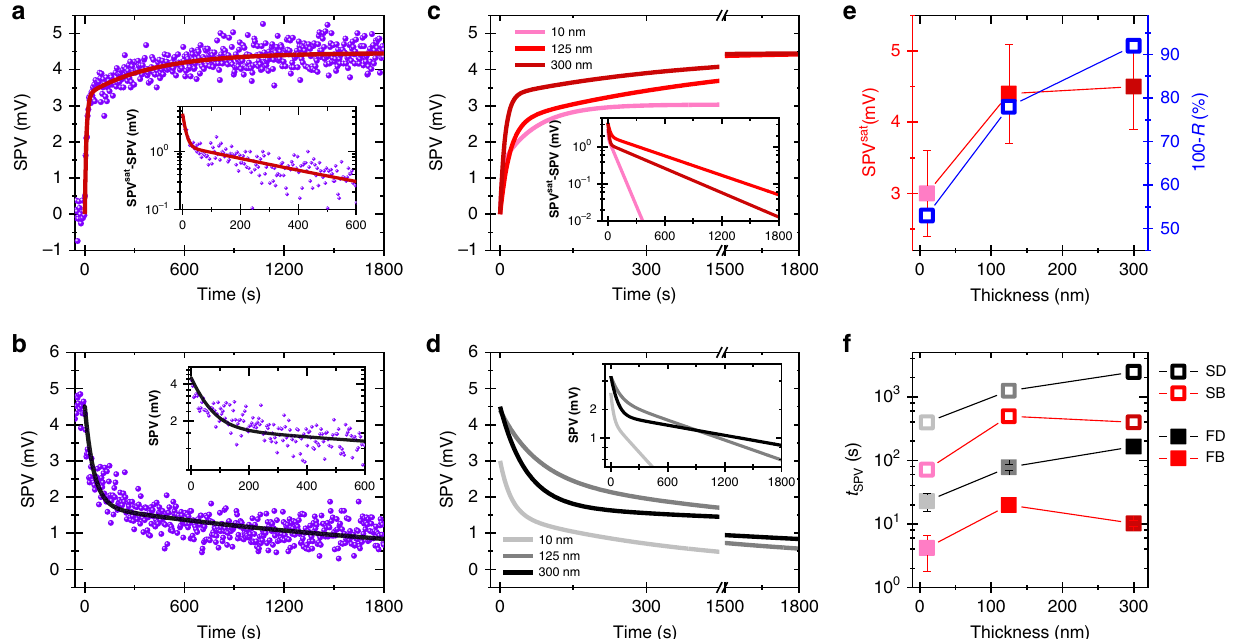
Fig. 4 Surface photovoltages dynamics and amplitudes supported by composite nanostructures. a , b Typical increase and decrease of the surface- photovoltage amplitude as a function of time upon ON and OFF switching of a laser beam (inset: semi-log scale of the signal absolute value), respectively. The solid curves are the fi ts of the rise and decay obtained on a 4p-300 Al 2 O 3 substrate. c , d Fitted surface-photovoltage rise and decay with time of 3 composite nanostructures. Note that no signal could be measured on single Ag thin fi lm deposited on the fused silica substrate. e Amplitude of the surface- photovoltage signal and photon fl ux within the nanostructure (represented by the quantity “ 100-R (%) ” with R being the re fl ectance) plotted versus the composite nanostructure Al 2 O 3 top layer thickness. f Dynamics of the surface-photovoltage rise and decay under bright (B) and dark (D) conditions with the slow (SD, SB) and fast (FD, FB) component represented by the empty and fi lled symbols, respectively. All the measurements were completed on bare composite nanostructures, with a 633 nm photo-excitation and at ambient conditions with stabilized temperature and air humidity.